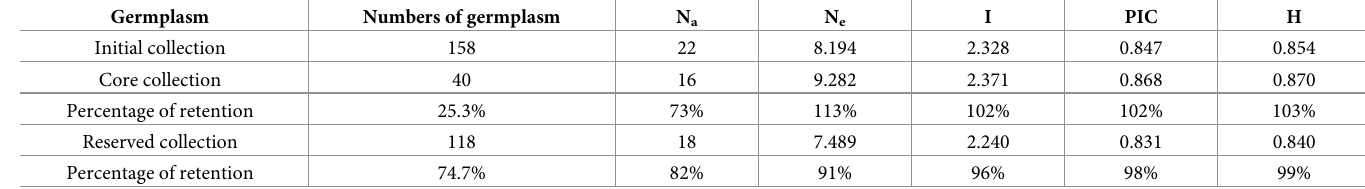
Table 2. Contradistinction of the genetic diversity between initial collection, core collection and reserved collection.